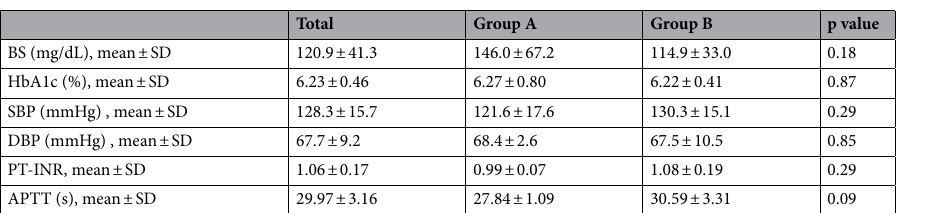
Table 2. Results of preoperative blood examination. BS blood sugar, HbA1c hemoglobin A1c, SBP systolic blood pressure, DBP diastolic blood pressure, PT-INR prothrombin time-international normalized ratio, APTT activated partial thromboplastin